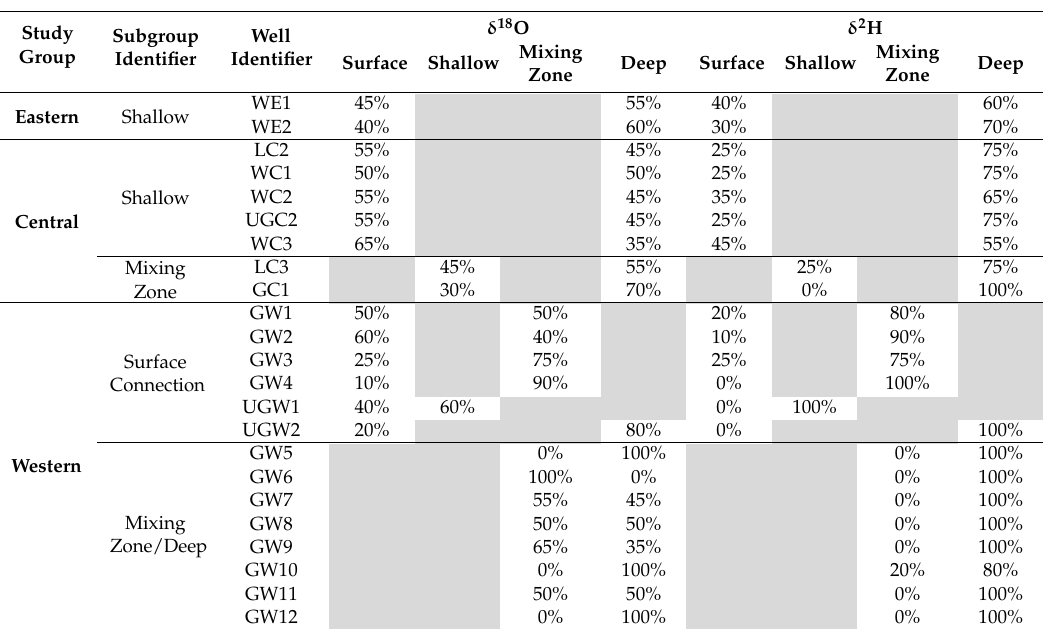
Table 5. Inverse modeling (Equation (1)) results of δ 18 O and δ 2 H values for groundwater collected from wells in the South Fork Palouse River Basin. Two potential source waters (Surface, Shallow, Mixing Zone, Deep) were chosen according to perceived representation of groundwater from wells indicative of characteristics associated with those recharge pathways, such as detectable nitrate (Surface) or most negative isotope values (Deep). Source waters not included in the inverse model are shaded in